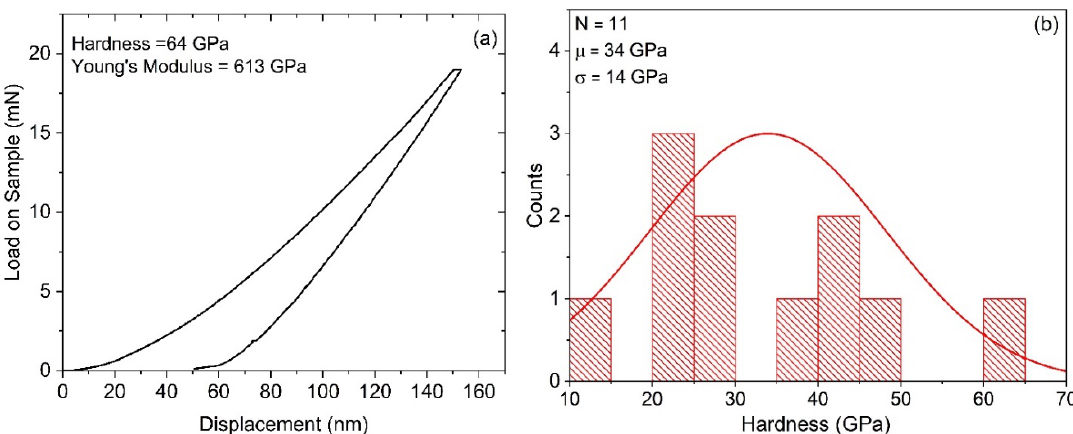
Figure 8. ( a ) Nanoindentation load–displacement curve from one location on the BC-1 coating at a depth of 150 nm. The extracted values of nanoindentation hardness and Young’s modulus are also indicated. ( b ) Histogram from 11 indents showing hardness values for sample BC-1.